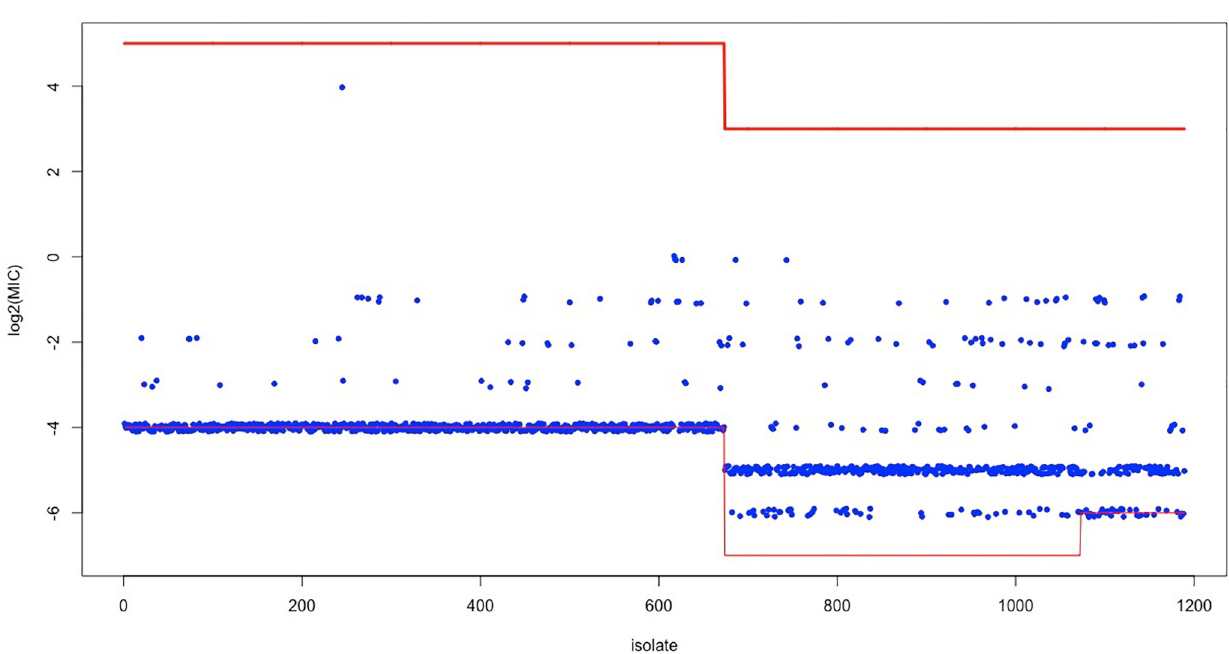
Fig 2. The CIPR data. Jittered MIC values in blue; the red lines show the experimental ranges.